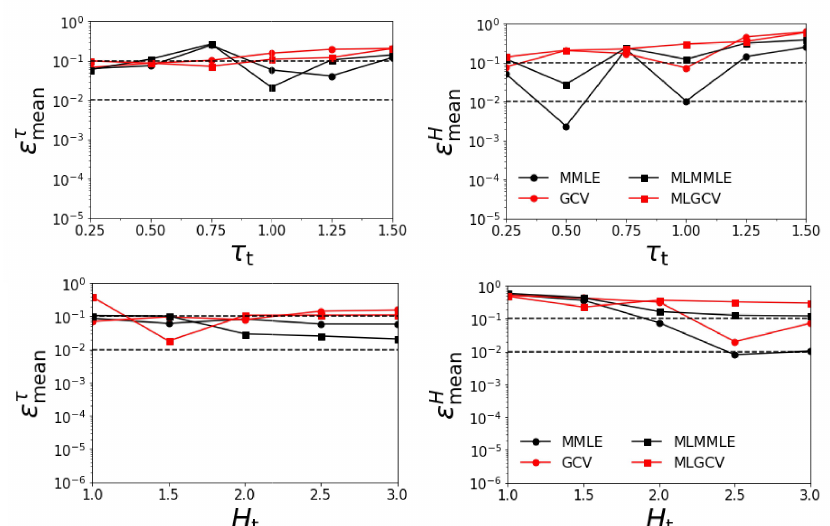
Figure 7. Relative errors ε τ mean and ε H mean versus τ t for H t = 3.0 km (upper panels) and H t for τ t = 1.0 (lower panels). The surface albedo is included in the retrieval and all aerosol models excepting the exact one are